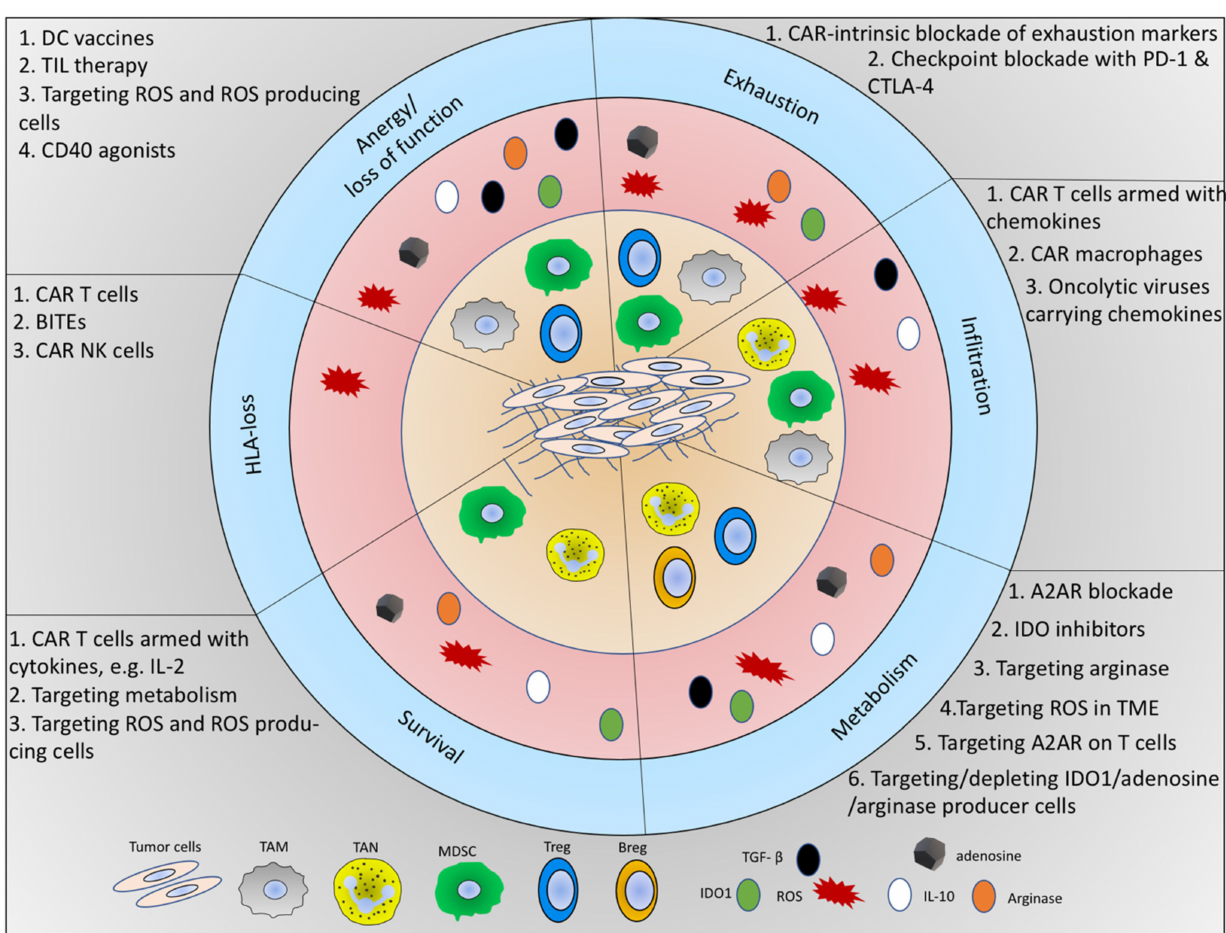
Figure 3. Schematic overview of immunosuppressive components of the TME, the immunosuppression on T cells, and the current immunotherapeutic strategies to overcome immunosuppression. The inner circle (light orange) shows the tumor cells and immunosuppressive immune cell types in the TME. The middle circle (red) indicates the immunosuppressive molecules. The outer circle (light blue) indicates the mechanism of inhibition on tumor-fighting immune cells (CD4+ T cells, CD8+ T cells, and NK cells). For each of these major mechanisms, the cells and the soluble factors released by the respective cells are shown in six slices. In the grey area of each slice, the current immunotherapeutic strategies are